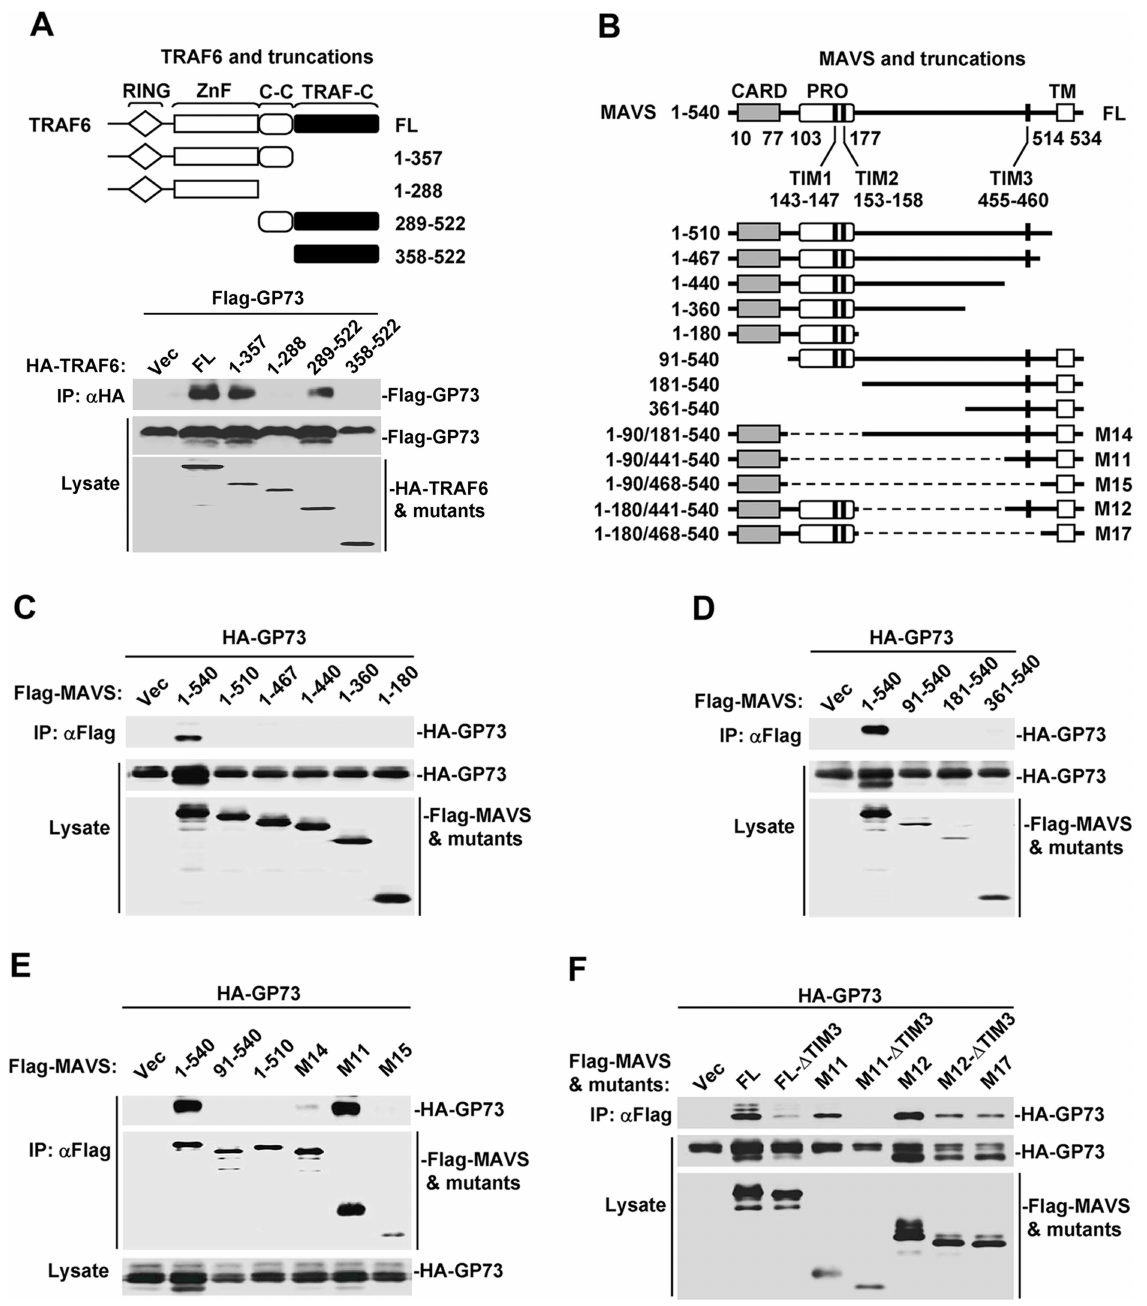
Fig 4. TRAF-interacting-motifs are required for the interaction of MAVS with GP73. ( A )Schemeof TRAF6 proteinand its mutants (top panel).HEK293 cells(2 × 10 6 ) wereco-transfected with GP73 (1 μ g) and indicated plasmids(3 μ g) for 24 h. Cell lysates were subjected to immunoprecipitationand WB with indicatedantibodies. ( B )Schemeof MAVS and its mutants. ( C , D , E and F ) Interactions of GP73 with MAVS and a series of truncations (C, D and E) or a series of TIM3 mutants (F). HEK293cells (2 × 10 6 ) were co-transfected with GP73 plasmid(1 μ g) and indicated plasmids(3 μ g) for 24 h. Celllysates were subjected to immunoprecipitation and WB with indicatedantibodies.